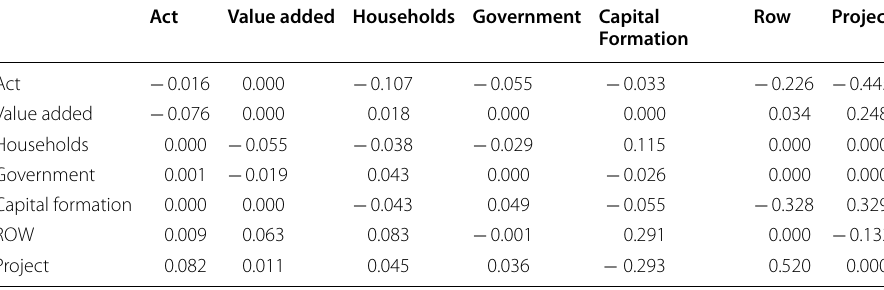
Table 4 Differences in the SAM coefficients between the operational and the construction period ( A t + 1 − A t